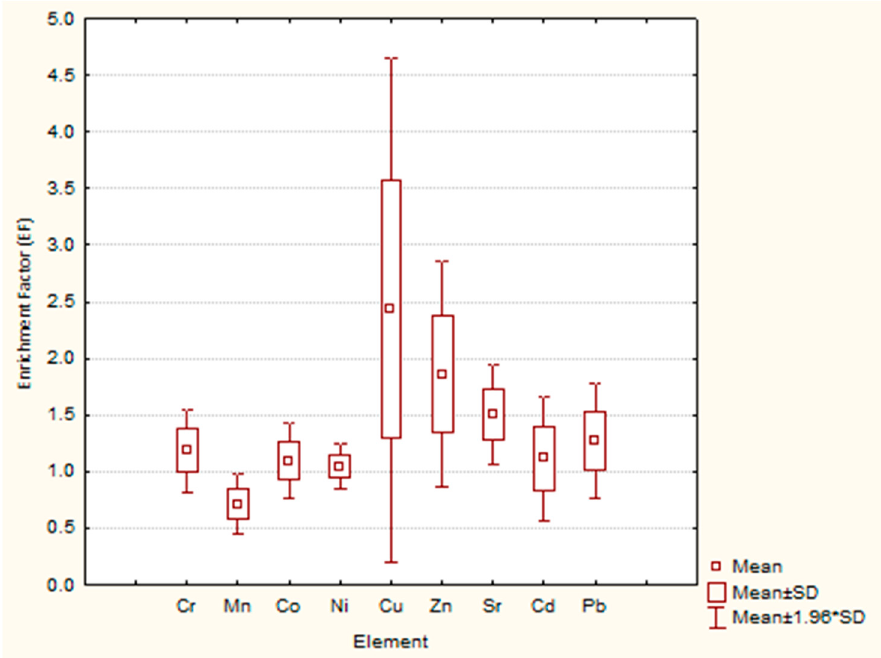
Figure 13. Box plot of Enrichment Factor (EF) of heavy metals in road